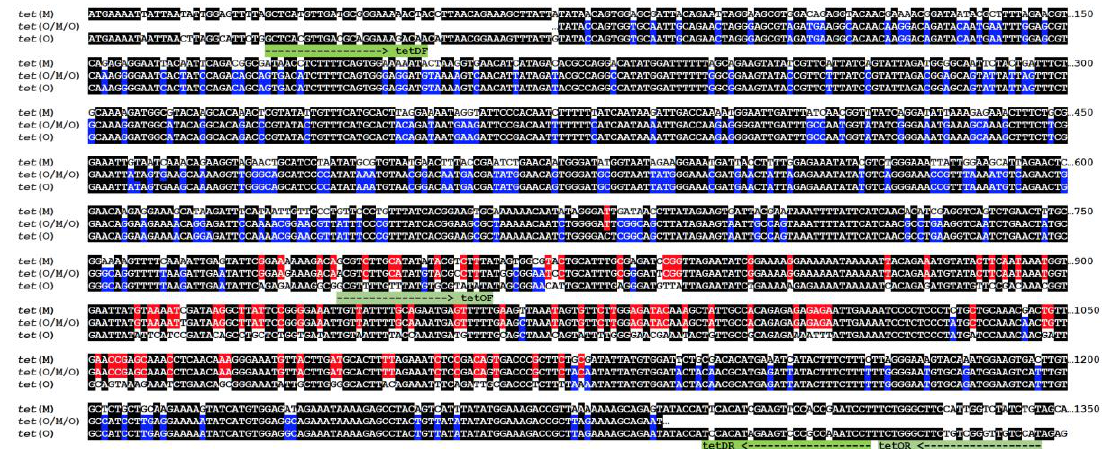
Figure 1. PCR detection of tet (O) sequences from Campylobacter . DNA samples were amplified by using specific primers (tet(O)-esp) or degenerated primers (tet-deg), according to conditions explained in the Material and Methods section and analyzed by agarose gel electrophoresis. Strains analyzed are: 1, HCC69 (susceptible to tetracycline); 2, HSA1 (resistant to tetracycline); 3, HCC30 (resistant to tetracycline). The figure presented is composed of images obtained from different gels.